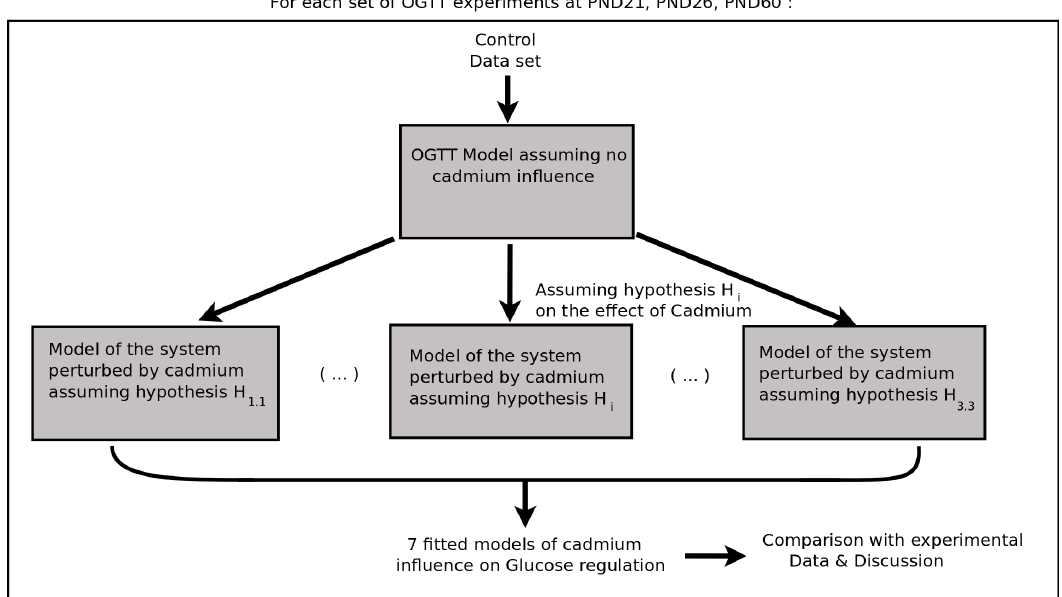
Figure 3. Modeling method to test hypotheses on the possible targets of cadmium. In the diagram, the index i spans hypotheses